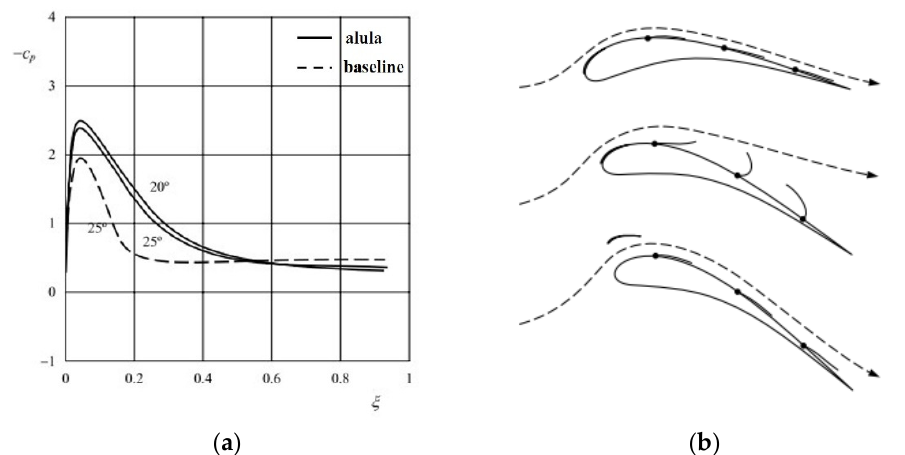
Figure 2. ( a ) Pressure coefficient on the upper surface of the airfoil (dashed line: airfoil without the alula; solid line: airfoil with the alula). ( b ) Flow pattern over the upper surface of the airfoil with the alula at different angles of attack [4].